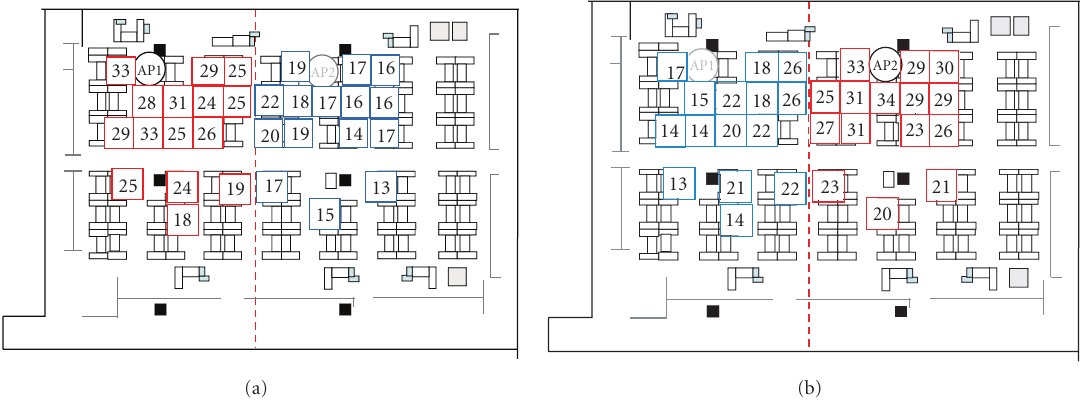
Figure 4: SNR distribution in an experimental environment corresponding to (a) AP 1 and (b) AP